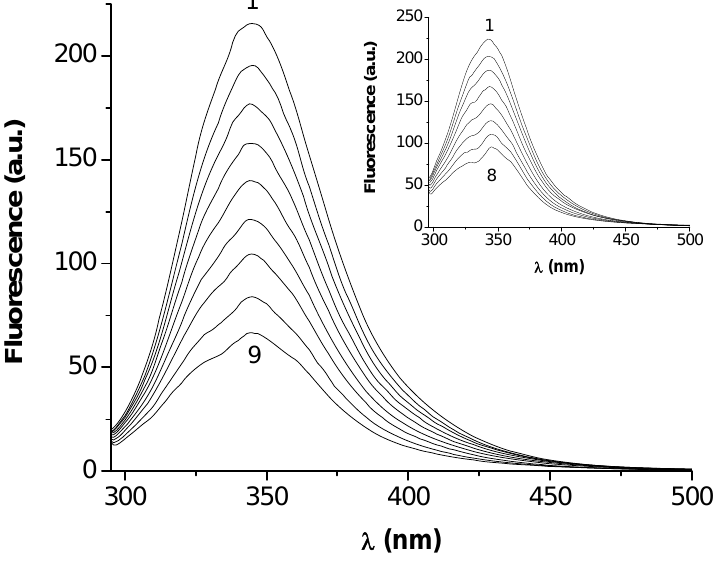
Figure 1. The quenching of BSA and HSA (inset) fluorescence at increasing HEBID concentrations. [HEBID]/[SA] = 0 (1), 0.48 (2), 0.97 (3), 1.67 (4), 2.53 (5), 3.83 (6),